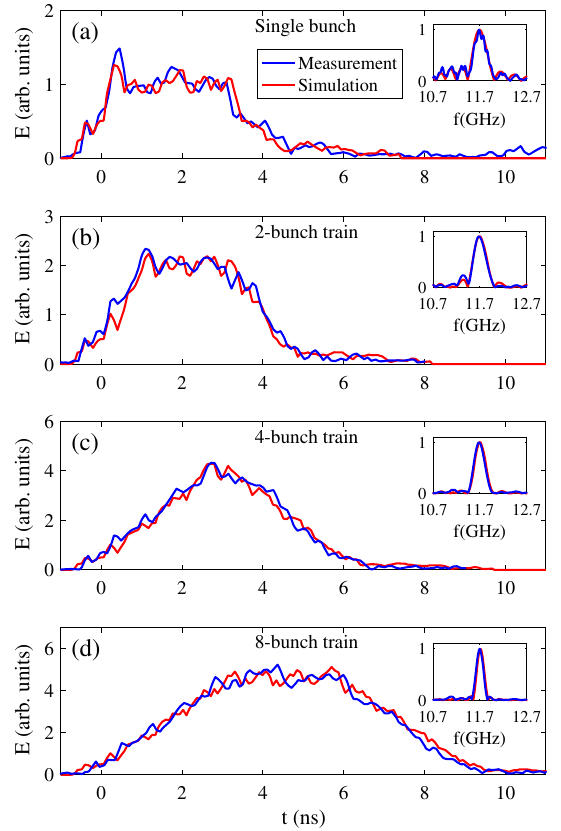
FIG. 16. Comparison of the field envelope and the spectrum (inset) of the coupler output rf signal between the experimental measurement and the CST Particle Studio simulation. The time, t ¼ 0 , is set to be the same as that in Fig.